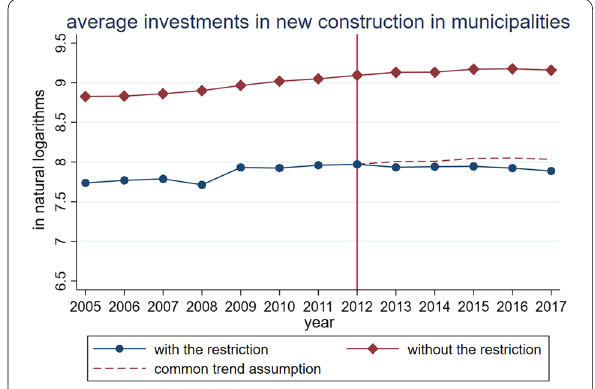
Fig. 2 Average investments in new constructions in municipalities to which the second home restriction applies and in the other municipalities with no legal changes (counterfactual) in natural